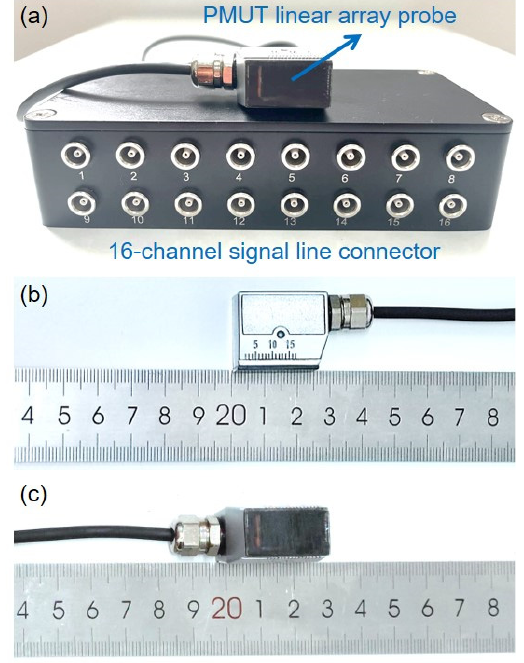
Figure 4. Pictures of the fabricated PMUT linear array probe: ( a ) PMUT probe with the connector, ( b ) lateral view of the PMUT probe, ( c ) bottom view of the PMUT probe.